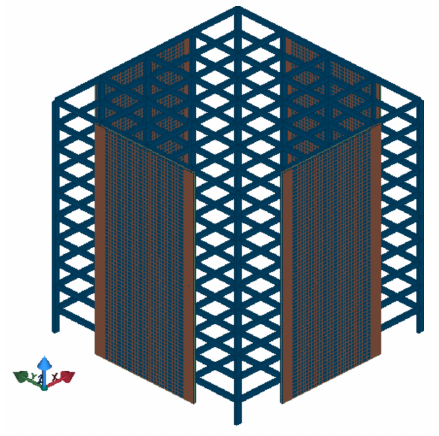
Figure 13. Design reinforcement in the shear